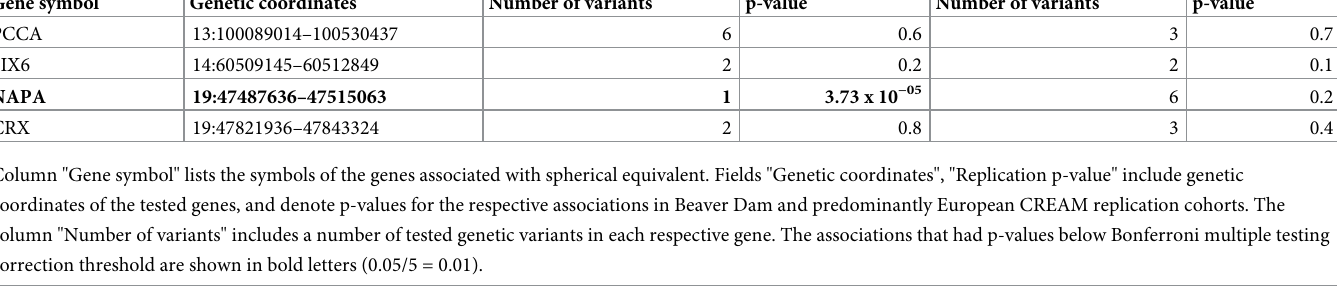
Beaver Dam (N = 1740)